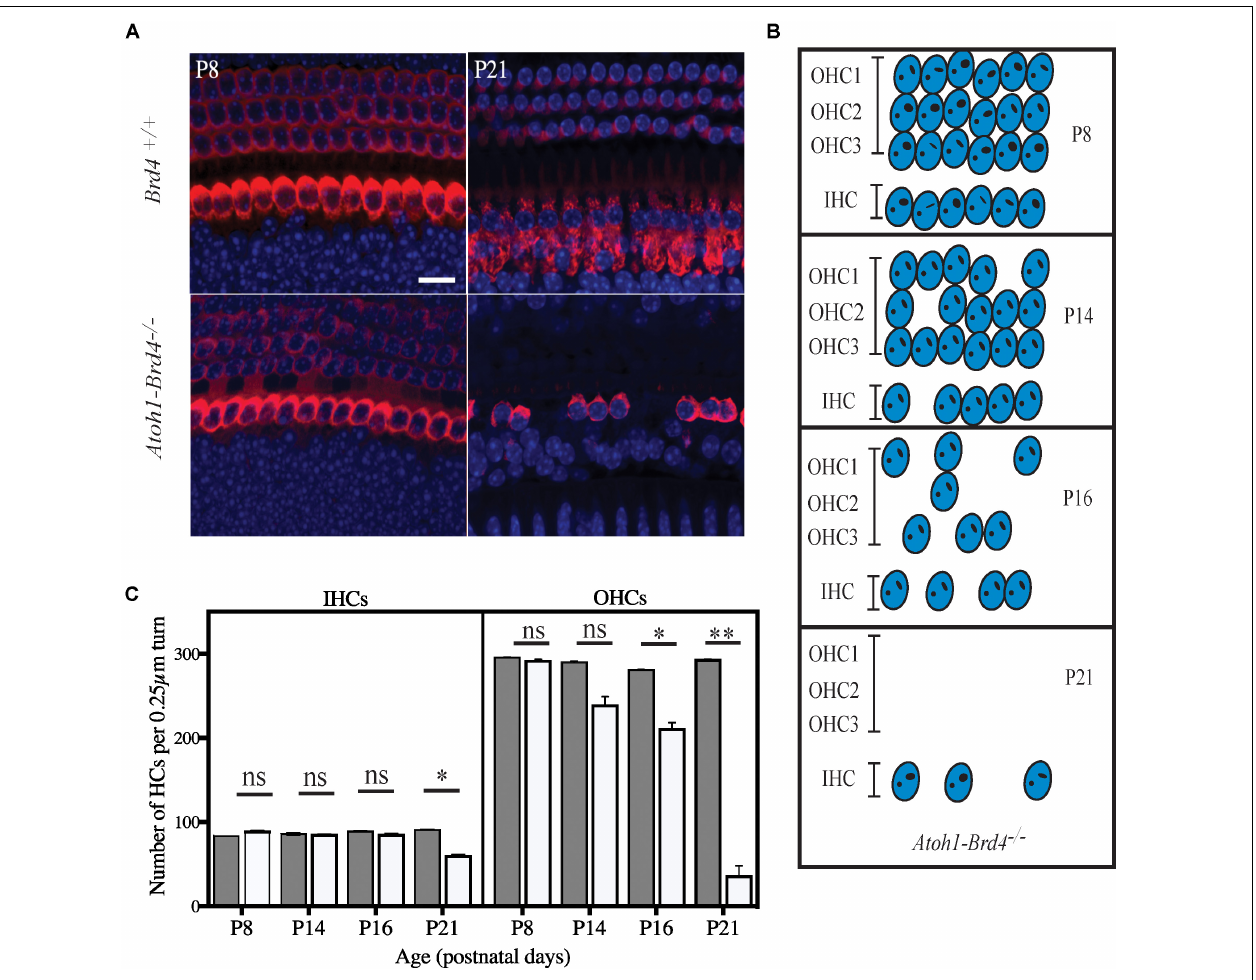
FIGURE 4 | Severe hair cell loss. (A) Z-stack of Atoh1-Brd4 − / − mouse cochleae immunolabeled with HC marker Myo7a (red) and DAPI (blue) (scale: 10 µ m) showed severe HC loss at P21 with more OHC death compared to IHCs. (B) A schematic representation of HC loss at different ages. (C) Graphical representation of the quantification of the number of OHCs and IHCs (per 0.25 µ m turn of cochlea) of the cochlea at different developmental stages (white, Atoh1-Brd4 − / − ; gray, Brd4 + / + ). The error bars indicate the SEM (Standard T -test was performed to determine the significance of the experiment, ∗ p < 0.05, ∗∗ p < 0.01, ∗∗∗ p < 0.001, ns-not